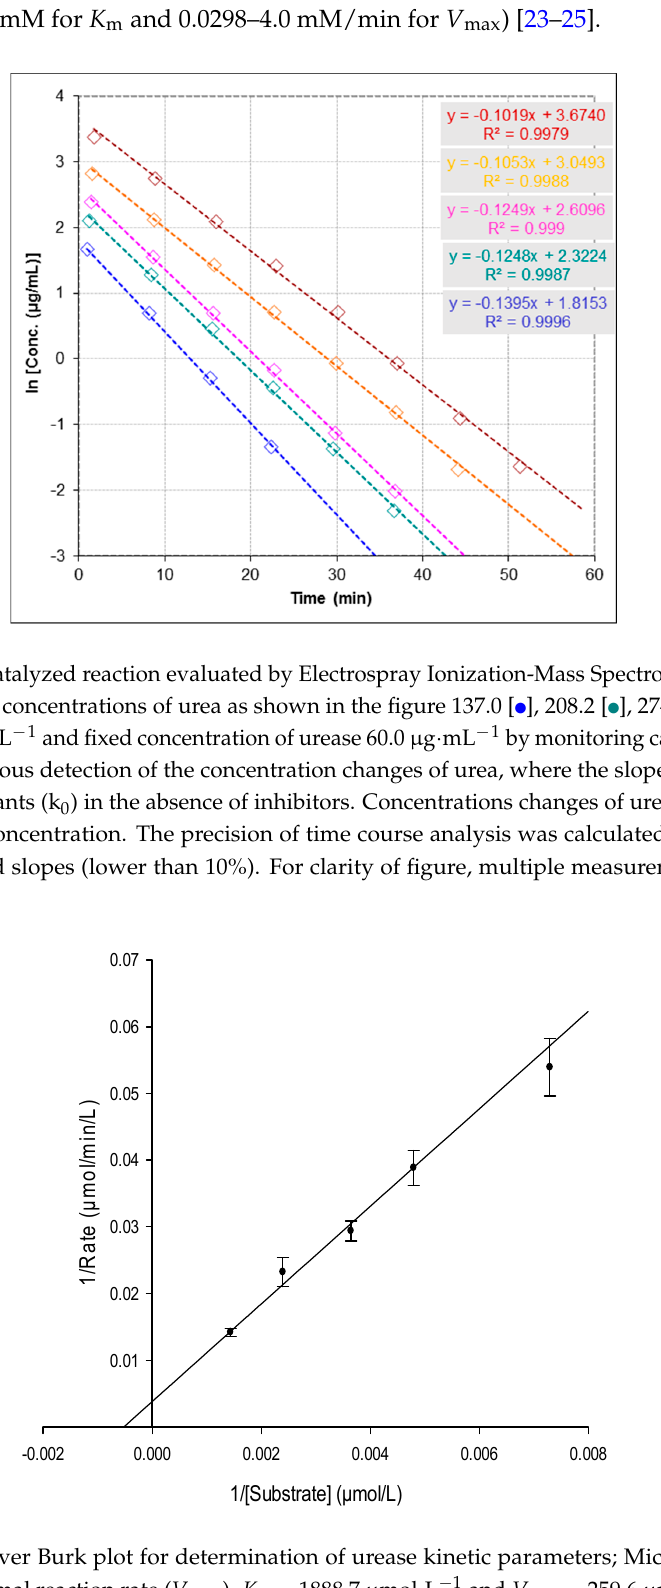
Figure 3. Lineweaver Burk plot for determination of urease kinetic parameters; Michaelis constant ( K m ) and the maximal reaction rate ( V max ). K m = 1888.7 µmol ∙ L − 1 and V max = 259.6 µmol ∙ L − 1 ∙ min − 1 . R 2 = 0.99.